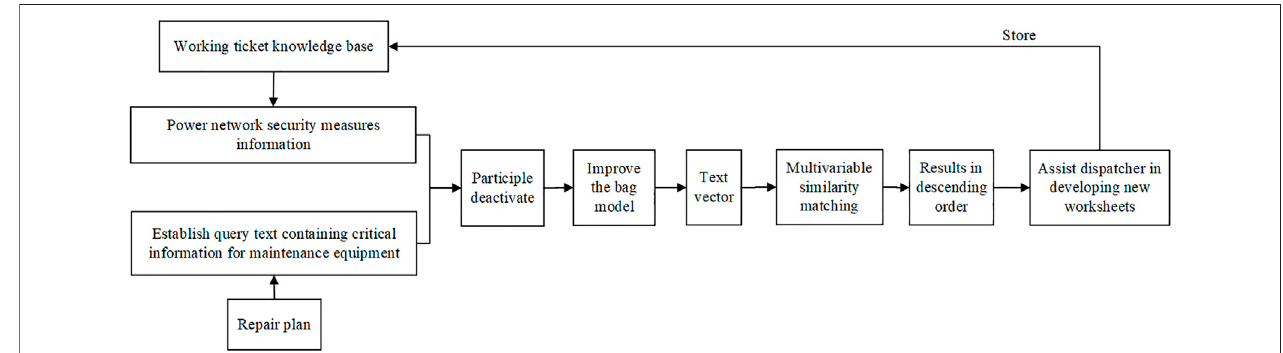
FIGURE 5 | The intelligent fi lling model of power grid work tickets.